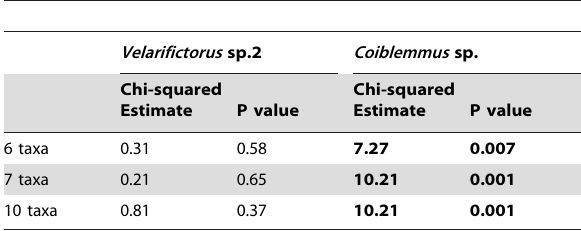
Table 6. Binomial Test results for proportions of correct classification of Velarifictorus sp.2 and Coiblemmus